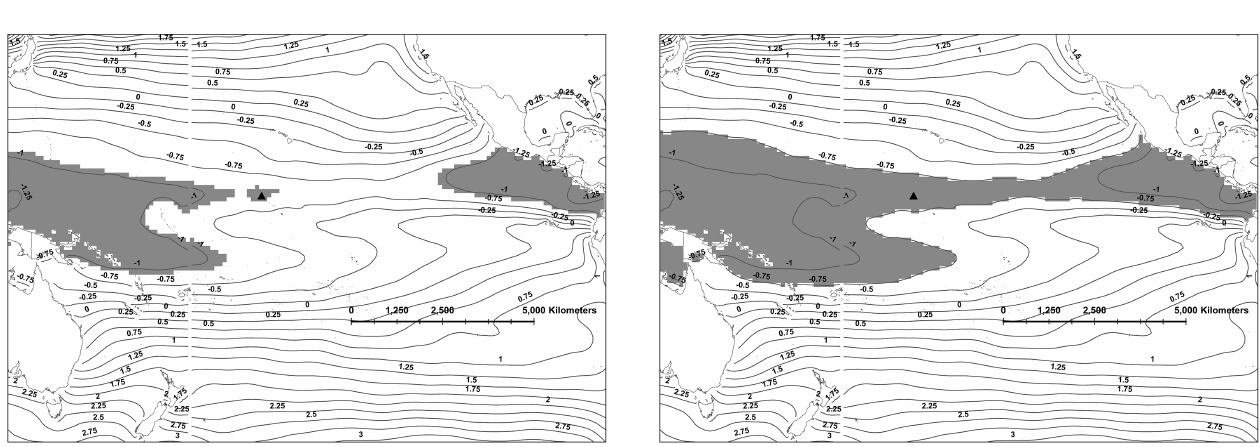
Figure 1. Oxygen isoscape (shaded in gray) showing the area in which we would expect our sea turtles to have resided throughout the life of the barnacles tested. This isoscape was calculated using an oxygen isotope ratio of − 0.951 δ 18 O c . PANWR is located within this area and depicted by the black triangle. Solid lines are contours of predicted oxygen isotope ratios in barnacle calcite ( δ 18 O c ) .